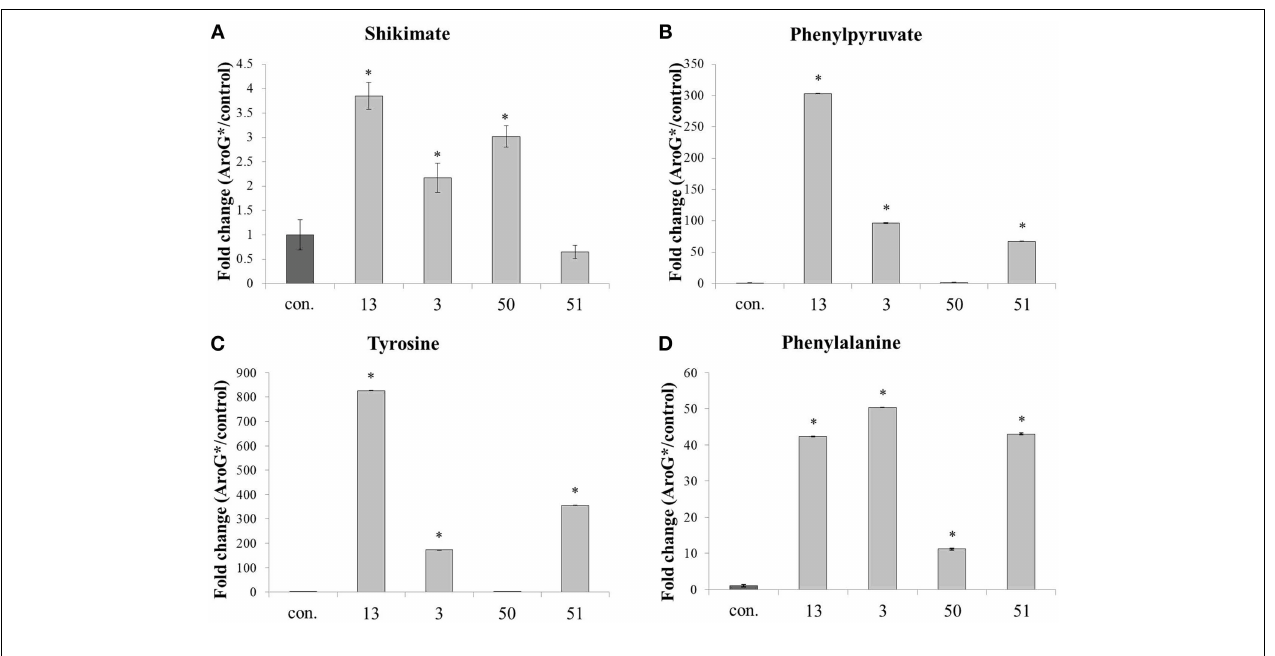
9 of growth. Bars on top of the histograms indicate standard errors (In the control n = 6 , including 3 samples from each of the two lines, while in the AroG * lines n = 3 ). Statistical significance was analyzed by One-Way ANOVA, followed by Dunnett’s post–hoc test. Asterisks indicate P ≤ 0